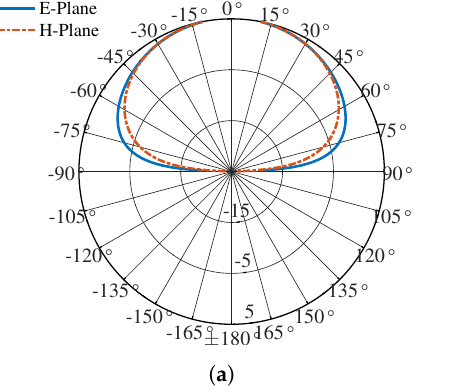
Figure 16. Simulated V-pol ( a ) and H-pol ( b ) radiation patterns at